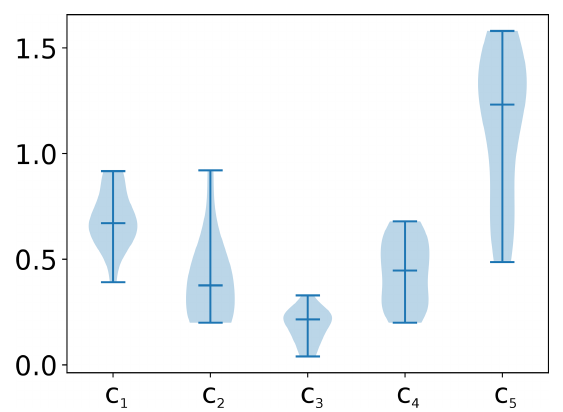
Figure A2. Distribution of coupling coefficients obtained after fit- ting the test model to the Fluxnet sites. Shown here are the distribu- tions used for generation of homoscedastic time series.